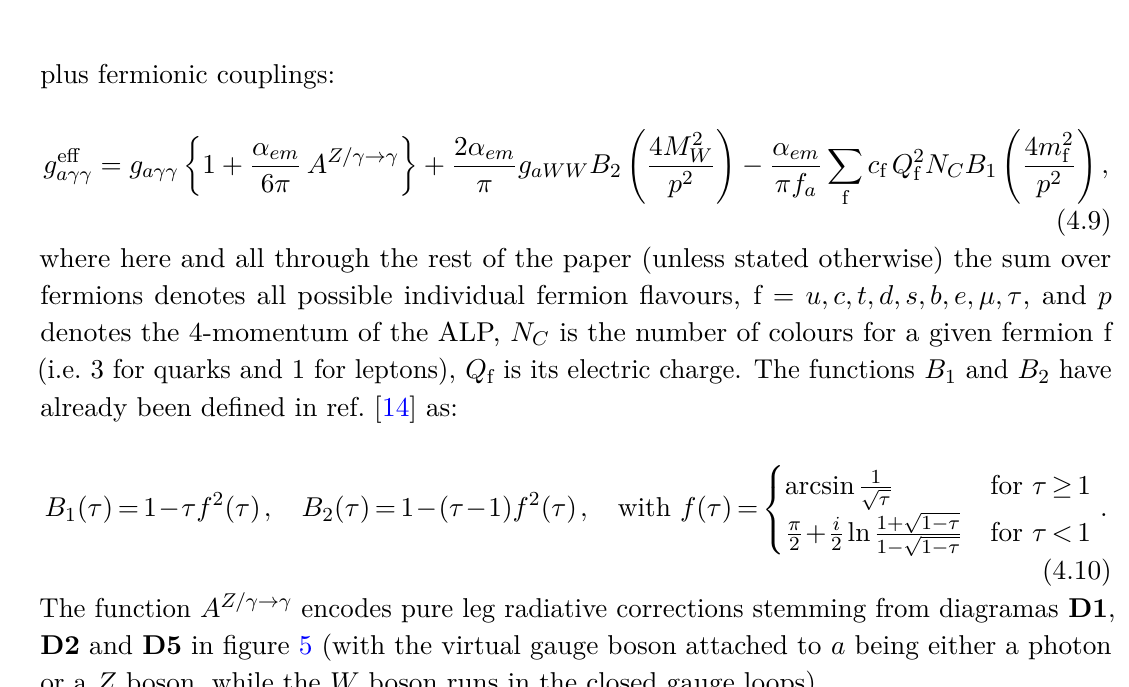
Figure 5 . One-loop diagrams contributing to the correction to the external gauge boson legs. Diagrams with Goldstone bosons and Higgs tadpole diagrams are included. Notice that diagrams D3 and D4 are only present for a Z or W boson external